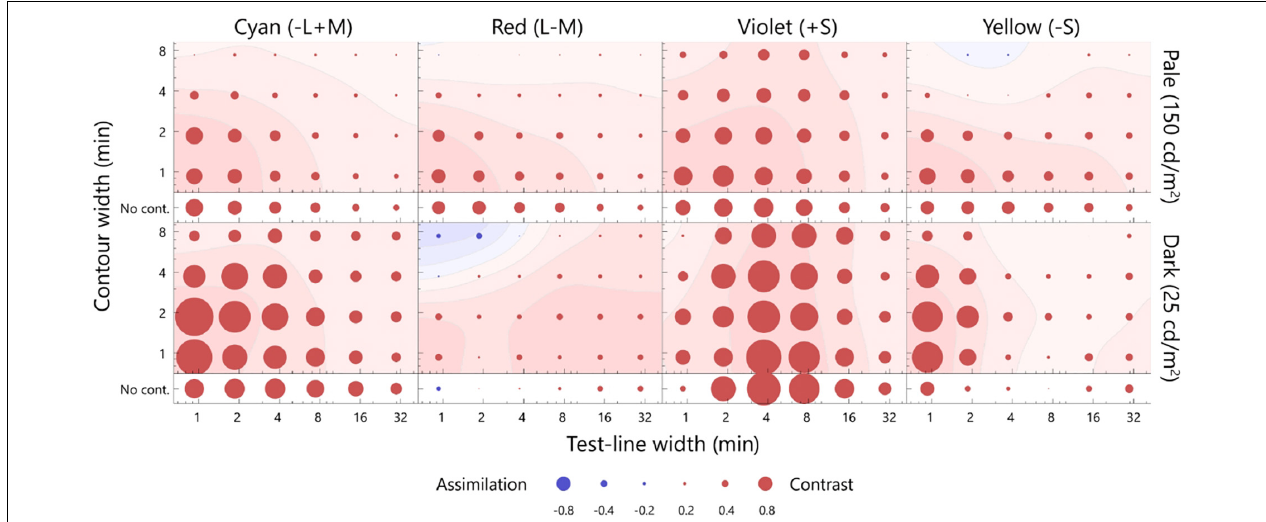
FIGURE 6 | The difference between the matching and artifact. The difference was estimated by subtracting the artifact from the matching on the MB chromaticity, and considered as the neural factor of the chromatic induction. The upper row presents the pale test line, and the lower row presents the dark test line. The smoothed contour plots were plotted using the same calculation as that employed for Figure 4 . The format is the same as that of Figure 4 .